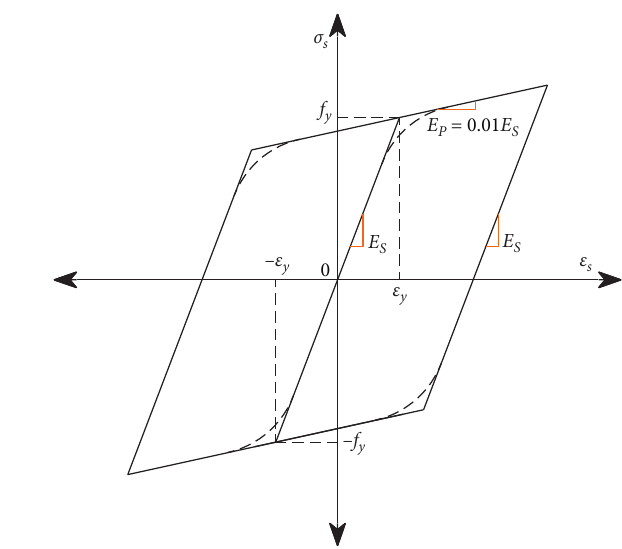
Figure 7: Stress-strain relationship of steel.